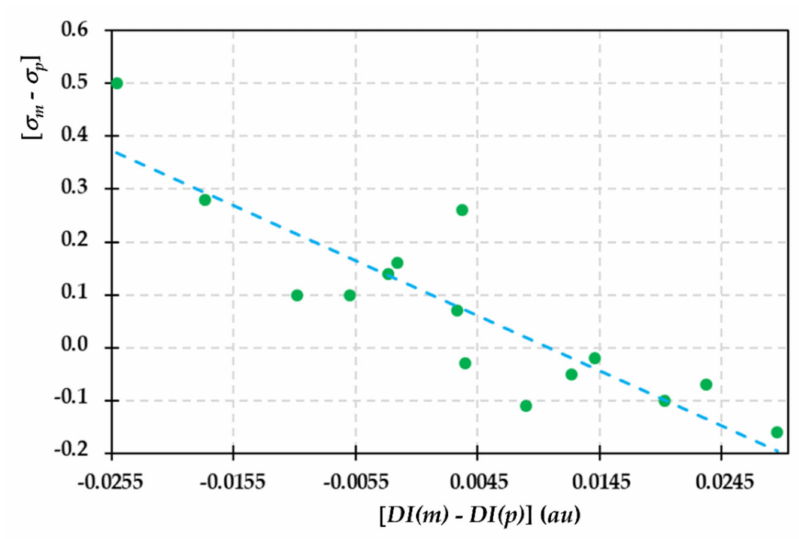
Figure 4. Correlation between σ m − σ p , as taken from Ref. [56], and DI( m ) − DI( p ), as calculated in this work. The linear regression coefficient is R 2 = 0.7649. The oxido group has been excluded from the data as it deviates quite a lot from the general